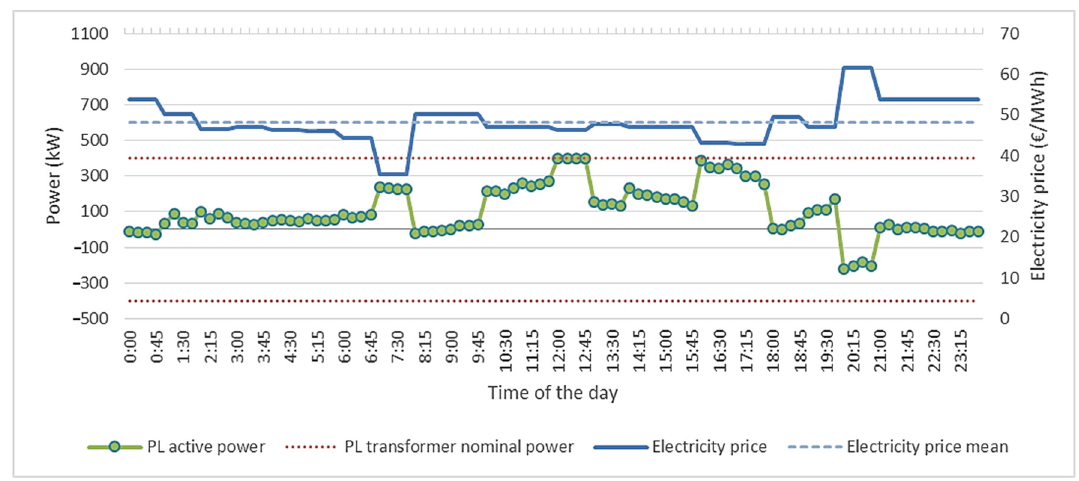
Figure 12. PL’s active power in scenario 5 and electricity price.